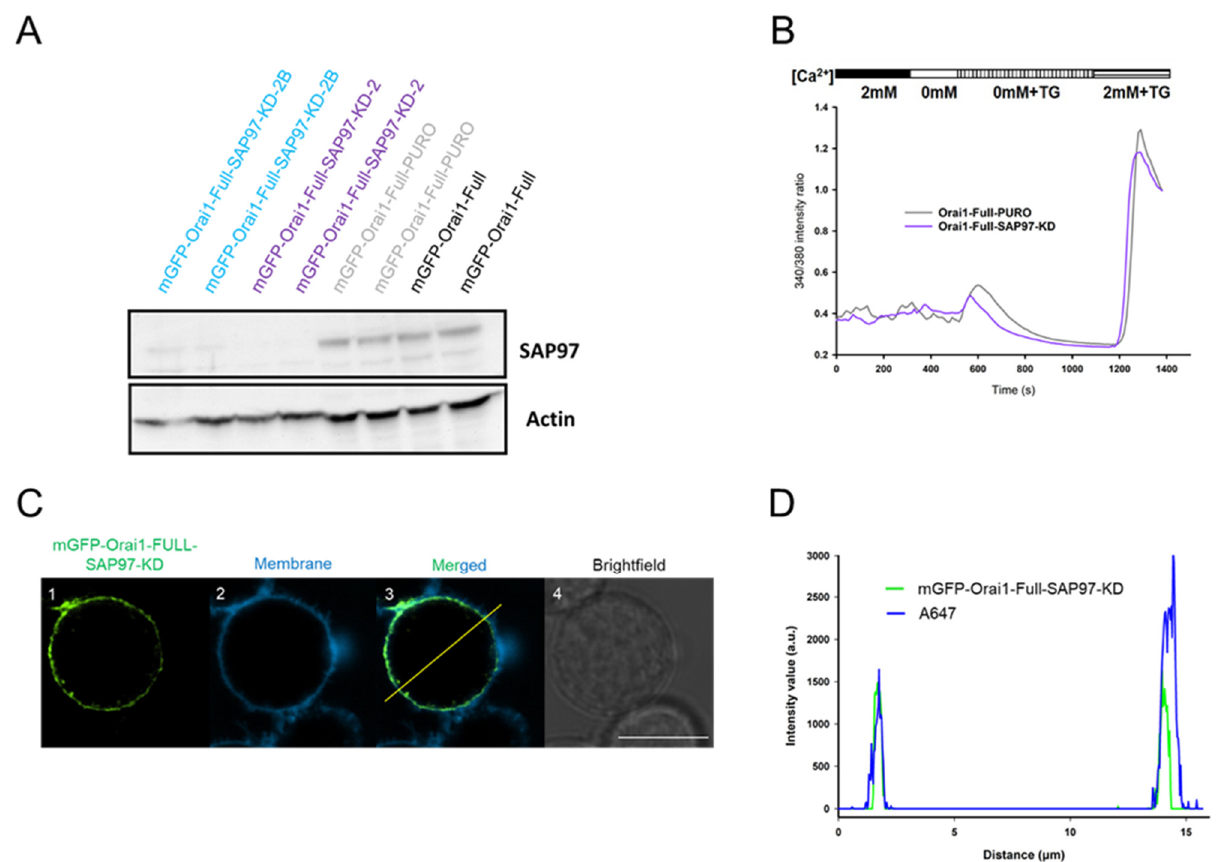
Figure 6. Knockdown of SAP97 in Jurkat cells preserve SOCE and Orai1 membrane targeting. ( A ) Western blot experiments of mGFP-Orai1-Full expressing Jurkat (black), mGFP-Orai1-Full-PURO (grey), mGFP-Orai1-Full-SAP97-KD2 (purple) (later we used this cell line and named it mGFP-Orai1-Full-SAP97-KD cell line) and mGFP-Orai1-Full-SAP97-KD2B cells (cyan) probed with a specific antibody against SAP97 (the expected size 130 kDa, each sample was loaded in duplicates). Actin was used as an expression control with an approximate size of 42kDa. (Knock-down efficiency was ca. 96%) Full-sized gel image is shown in Figure S3. ( B ) Cytosolic Ca 2+ measurements using FURA-2 in mGFP-Orai1-Full-PURO (grey) as a transduction control and mGFP-Orai1-Full-SAP97-KD (purple) cells. The representative traces are the average of 18 cells (mGFP-Orai1-Full-PURO) and 21 cells (mGFP-Orai1-Full-SAP97-KD). ( C ) Confocal images of mGFP-Orai1-Full-SAP97-KD cells stably expressing mGFP-Orai1-Full channels: ( C1 ) mGFP signal of Orai1-Full channel (green) in SAP97-KD cells. ( C2 ) Alexa Fluor TM 647 NHS Ester fluorescence of the plasma membrane (blue). ( C3 ) Fusion of green and blue channels, note that their overlap. ( C4 ) Brightfield image of the mGFP-Orai1-Full-SAP97-KD cell in shown in Ca-Cc. Scale bar is 10 µm. ( D ) Pixel-by-pixel intensity profile analysis of mGFP-Orai1-Full channels in mGFP-Orai1-Full-SAP97-KD cell along the line indicated in the merged image (Cc): green: mGFP-Orai1-Full; blue: membrane, Alexa-647 NHS ester.